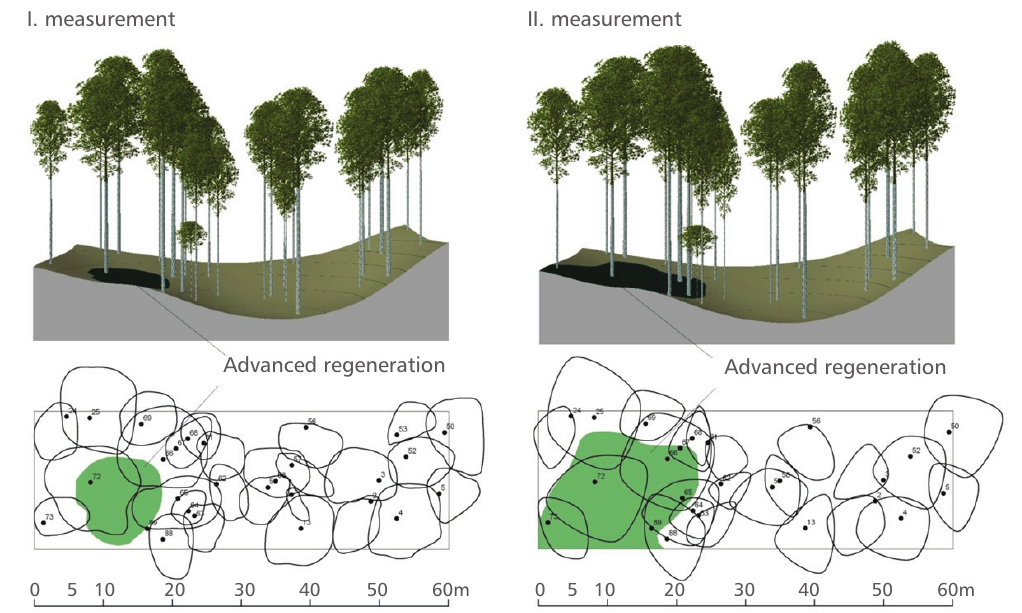
FIGURE 5. Scheme of the development of initiated advanced regeneration between two